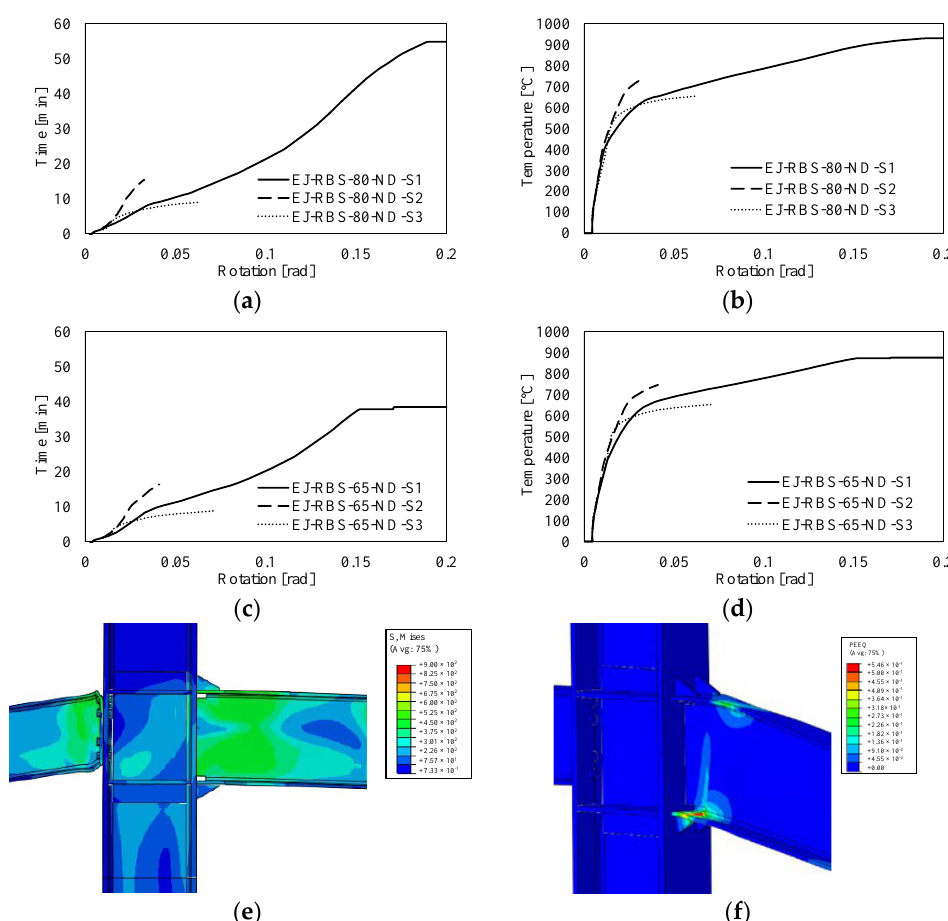
Figure 8. FE results of undamaged external joints subjected to elevated temperature in terms of time-rotation curves ( a , c ), temperature rotation curves ( b , d ) and Von Misses and PEEQ distribution ( e , f ).